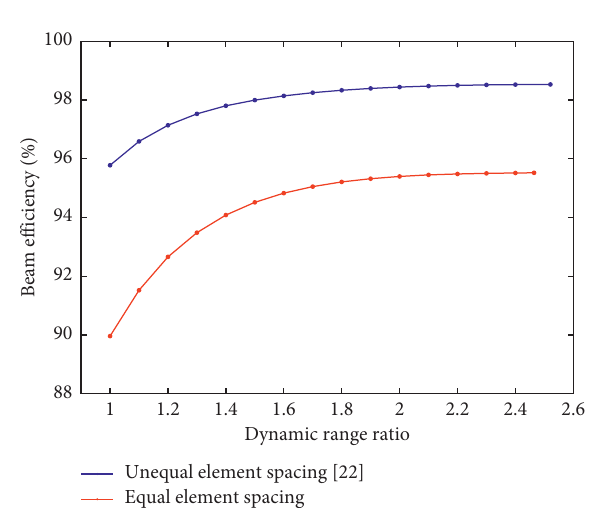
Figure 12: Beam efciency of pencil beam arrays with minimum SLP and constrained DRR, obtained for unequal element spacing from [22] and for equal element spacing of λ /2. Both arrays have 32 elements and beamwidth of 6 °